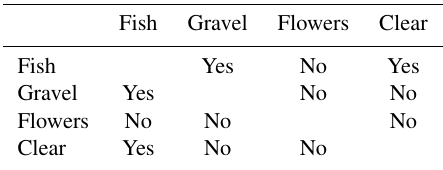
Table 7. Significance of differences in the means of IWV samples using a Student’s t test across all stations. “Yes” means that the means are statistically different at the 0.05